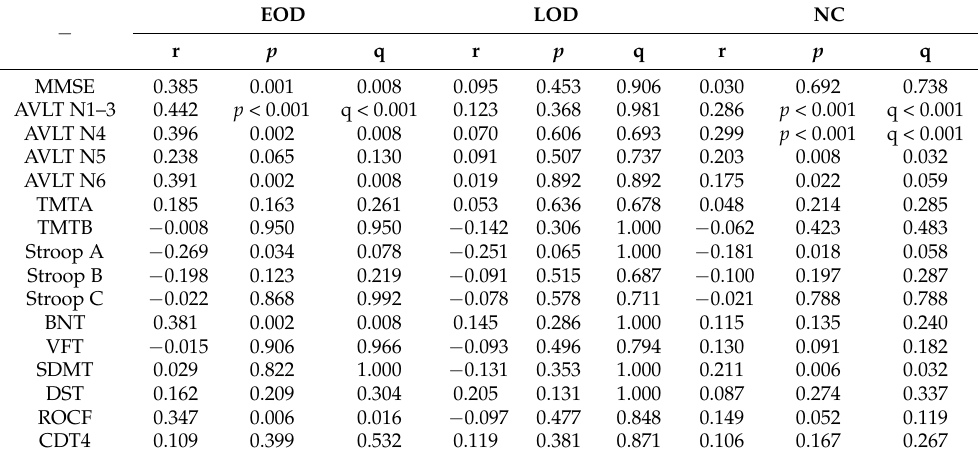
Table 3. Correlation analyses between OI and cognitive function in EOD, LOD and NC groups.